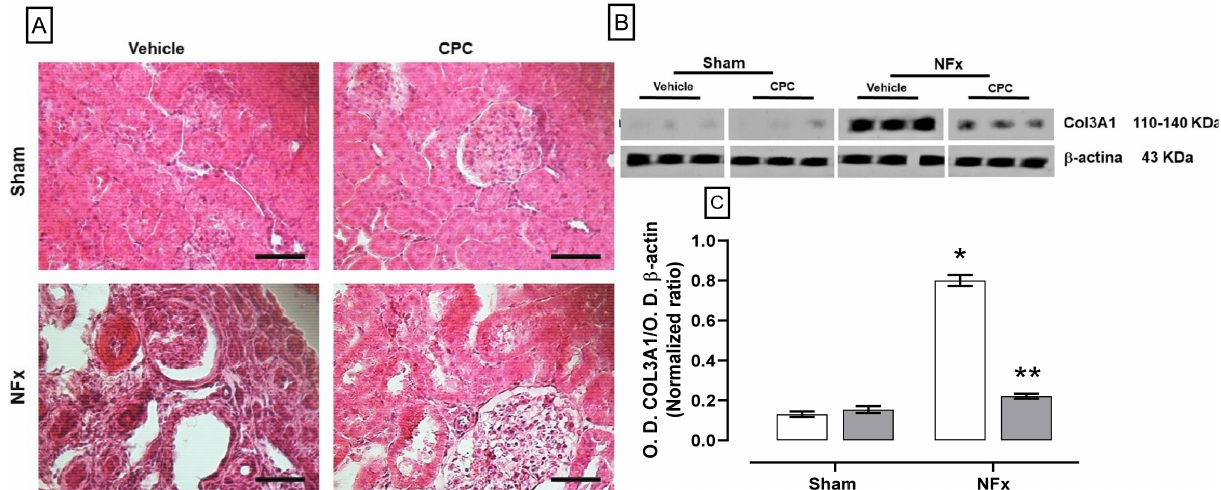
Figure 1. Effects on renal tissue for the four experimental groups. ( A ) Representative photomicro- graphs of the renal cortex stained by hematoxylin & eosin. The lower right bar of photomicrographs represents 250 µ m. ( B ) Blot of the COL3A1 expression. ( C ) Type III collagen expression of NFx rats. (*) p < 0.05 compared to the sham + vehicle group. (**) p < 0.05 compared to the NFx + vehicle group. Two-way ANOVA and SNK post hoc test.